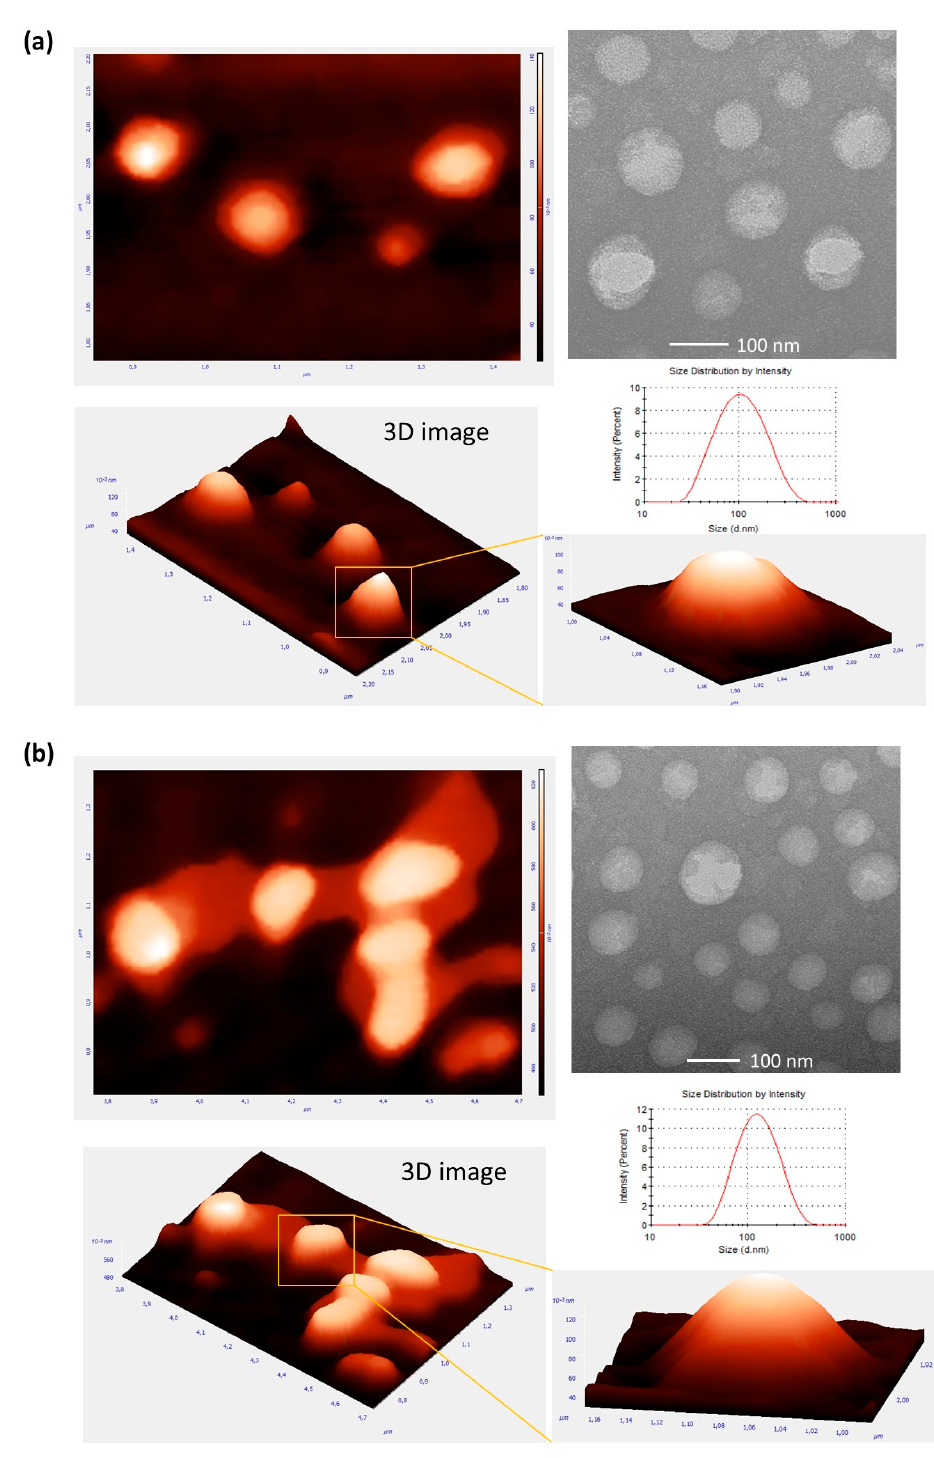
Figure 2. AFM and TEM images compared to DLS graphs of solid lipid nanoparticles: ( a ) system 1; and ( b ) system 7.